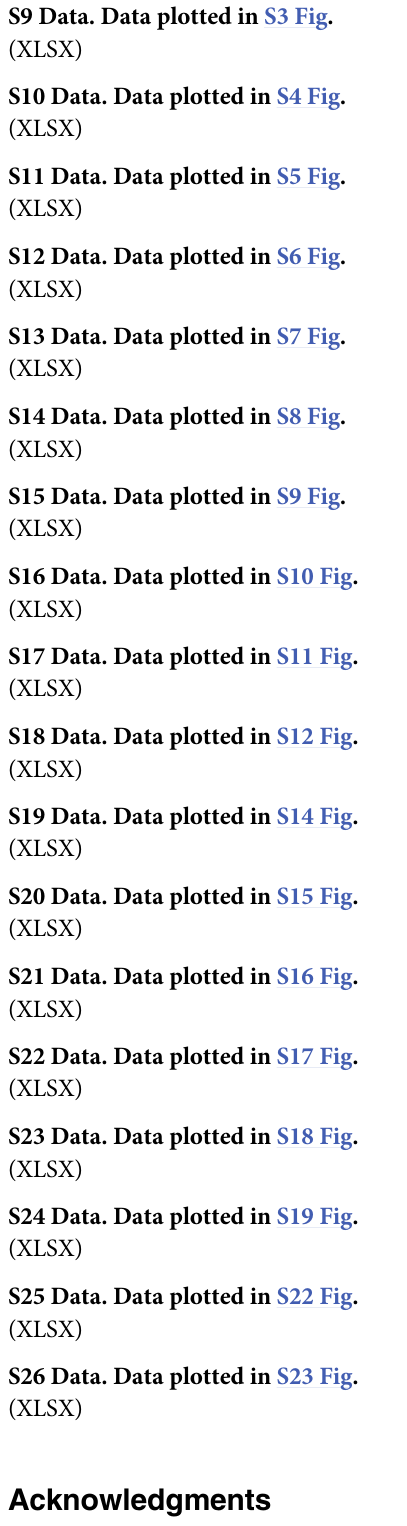
S10 Data. Data plotted in S4 Fig. S11 Data. Data plotted in S5 Fig. S12 Data. Data plotted in S6 Fig. S13 Data. Data plotted in S7 Fig. S14 Data. Data plotted in S8 Fig. S15 Data. Data plotted in S9 Fig. S16 Data. Data plotted in S10 Fig. (XLSX) S17 Data. Data plotted in S11 Fig. (XLSX) S18 Data. Data plotted in S12 Fig. S19 Data. Data plotted in S14 Fig. S20 Data. Data plotted in S15 Fig. S21 Data. Data plotted in S16 Fig. S22 Data. Data plotted in S17 Fig. S23 Data. Data plotted in S18 Fig. (XLSX) S24 Data. Data plotted in S19 Fig. (XLSX) S25 Data. Data plotted in S22 Fig. (XLSX) S26 Data. Data plotted in S23 Fig.